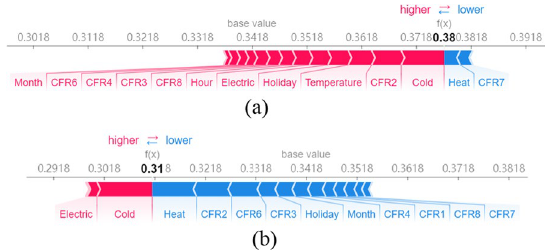
Fig. 8 Local SHAP value distribution of cold load prediction. ( a ) In summer. ( b ) In winter